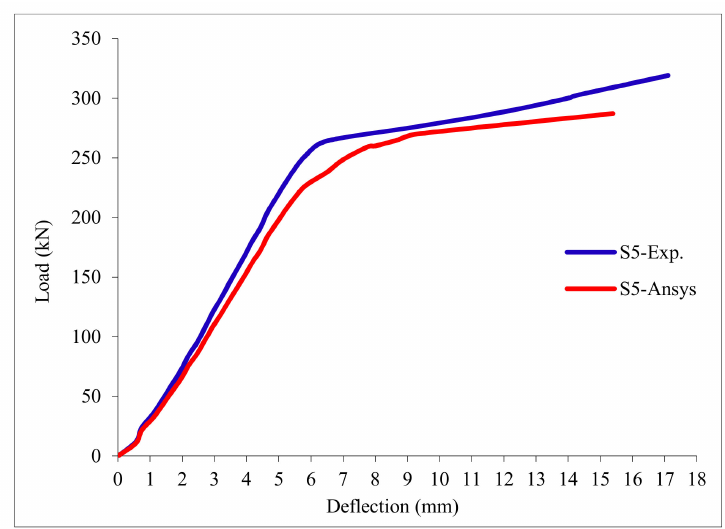
Figure 29. Load deflection curve for control slab S4.